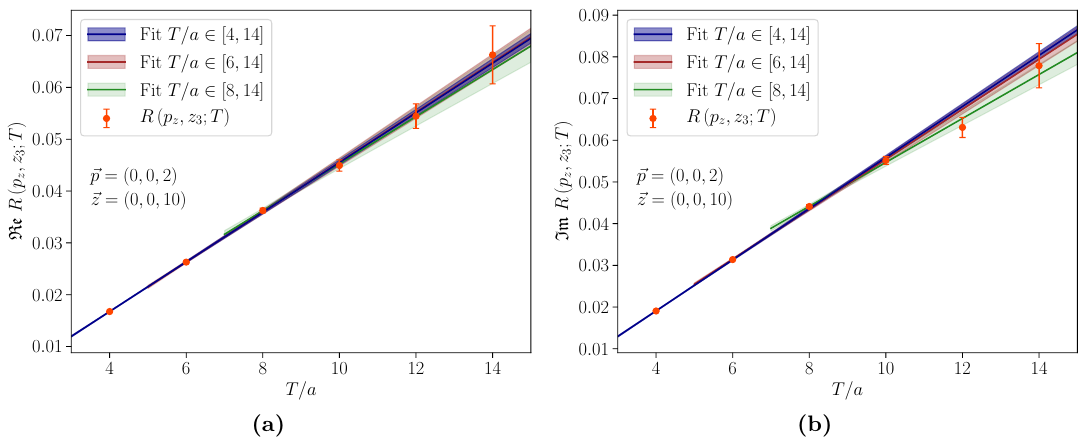
Figure 2. (a) Real and (b) imaginary summation data R ( p 3 , z 3 ; T ) for p 3 ’ 0 . 82 GeV and z/a = 10 , together with the linear fit (3.11) applied for different time series. The slope of each linear fit yields the bare matrix element, which is seen to be consistently determined for varied fitting